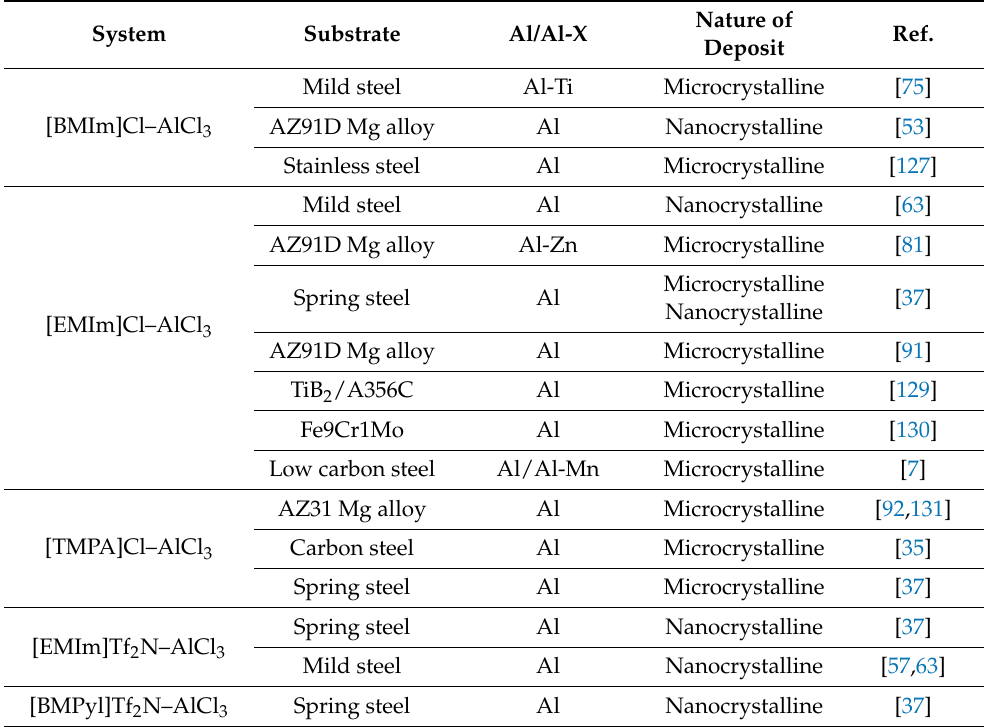
Table 9. Table showing the deposition of Al and Al alloys on most commonly used industrial-based substrates along with the ILs